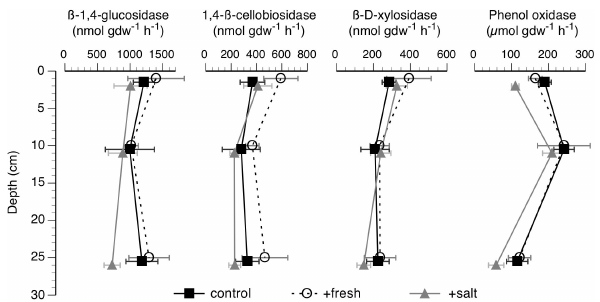
Fig. 3. Extracellular enzyme activity. Values for the control treat- ment are plotted at the midpoint of each depth interval, with depths for the + fresh and + salt treatments jiggered by ± 0.5cm to reduce overlap of symbols and error bars. Values are means ± standard de- viation, n = 5 plots per data